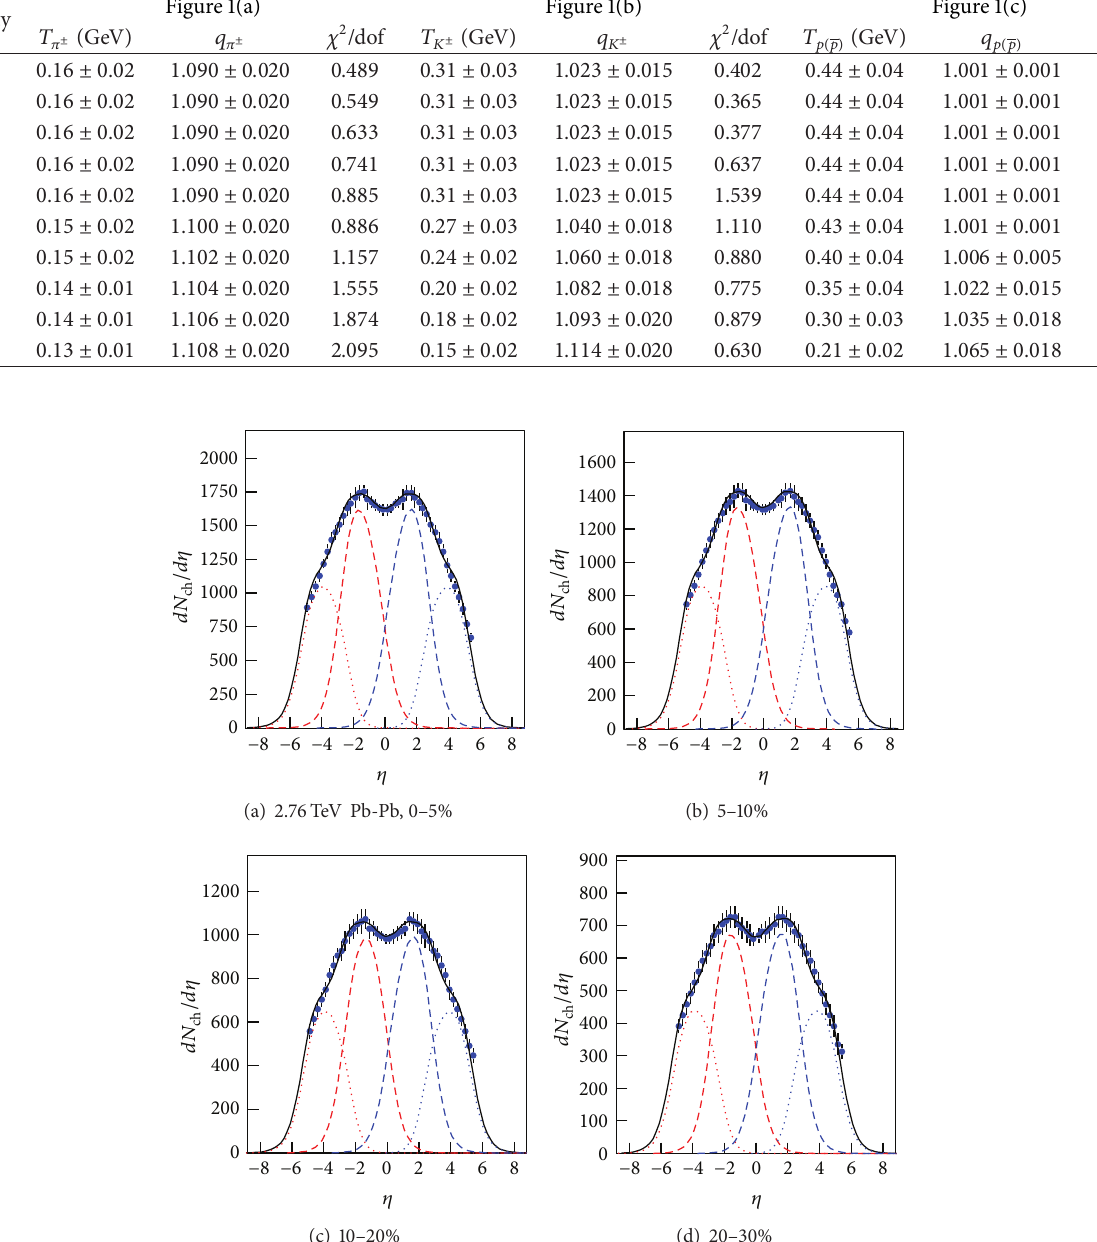
Table 1: Values of parameters and 𝜒 2 /dof corresponding to the curves for 𝜋 + + 𝜋 − , 𝐾 + + 𝐾 − , and 𝑝 + 𝑝 in Figures 1(a)–1(c), respectively. Figure 1(a) Figure 1(b) Figure 1(c) Centrality